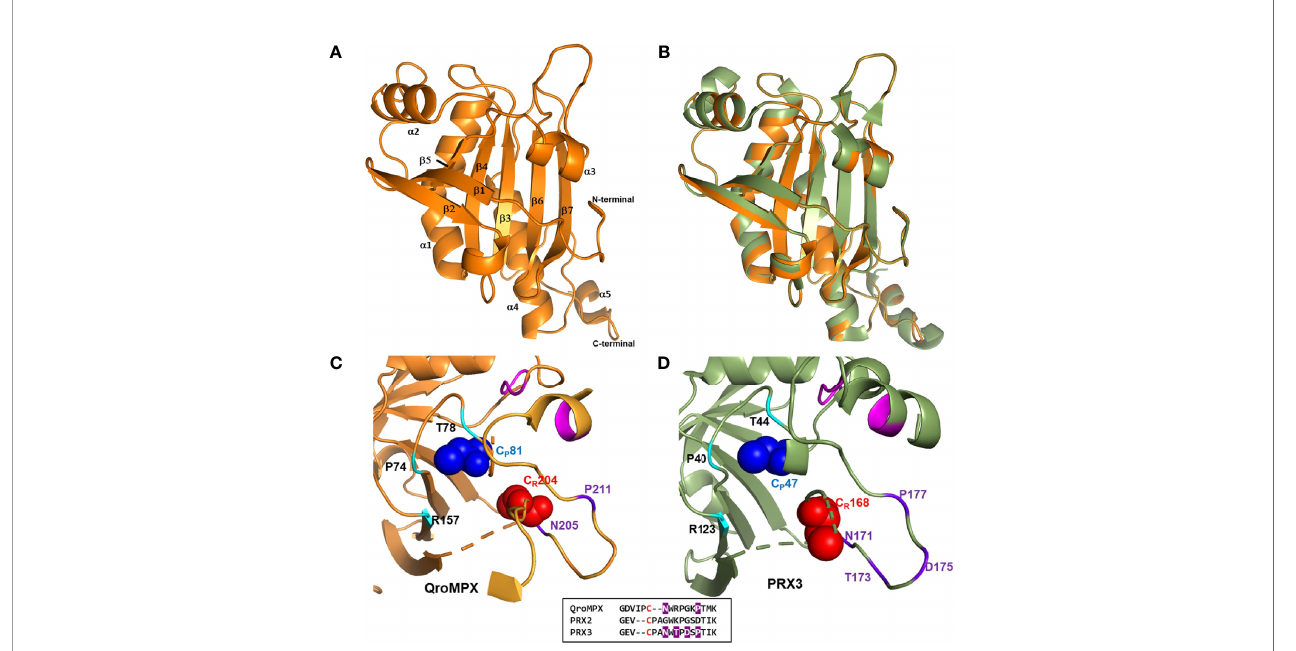
FIGURE 2 | QroMPX tertiary structure model. Modeling was performed as indicated in Materials and Methods. A) Monomer of the protein. Alpha-helices and beta sheets are indicated with the corresponding numbering. B) Overlap of QroMPX (orange) and human PRX3 (PDB 5JCG, green). C) The amino acids surrounding the peroxidatic (CP) and resolutive (CR) cysteine are shown for QroMPX. The GGLG and YF motifs are indicated in pink. The catalytic triad (PTR) is indicated in cyan. The amino acids that could participate in the resistance to hyper oxidation are shown in purple. The comparison of these amino acids in the sequences of QroMPX (QKE461.1), human PRX2 (ABB02182.1), and human PRX3 (PDB 5JCG) are shown in the lower box (in red resolutive cysteines, in purple amino acids involved in resistance to hiperoxidation). D) The position of the amino acids around the catalytic site in human PRX3 are shown with the same colors as in